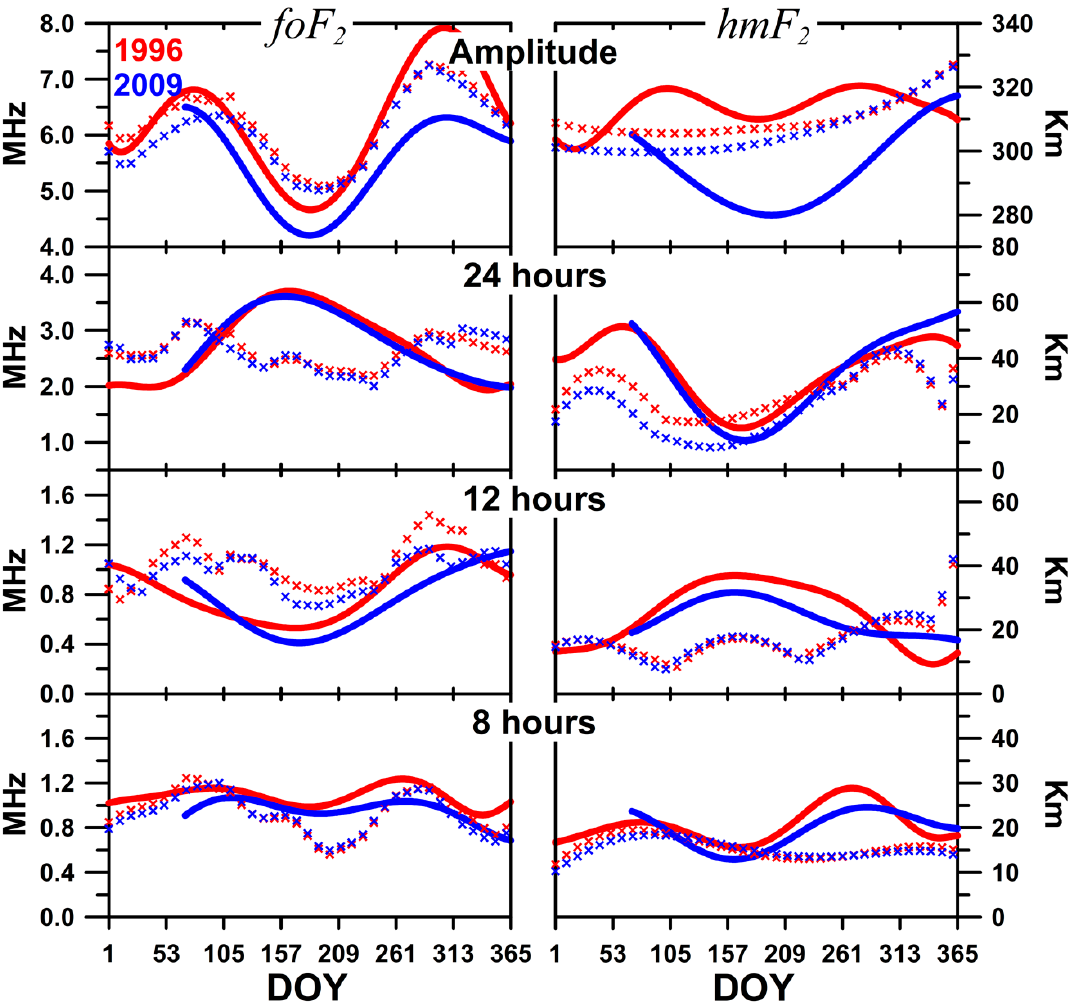
Figure 6 . Variability of the amplitude, diurnal, semidiurnal, and terdiurnal components of the best polynomial fitting of Figure 5 (continuous lines) and the parameters from IRI after applying the same methodology to which the data were submitted (crosses). Red and blue for 1996 and 2009, respectively.